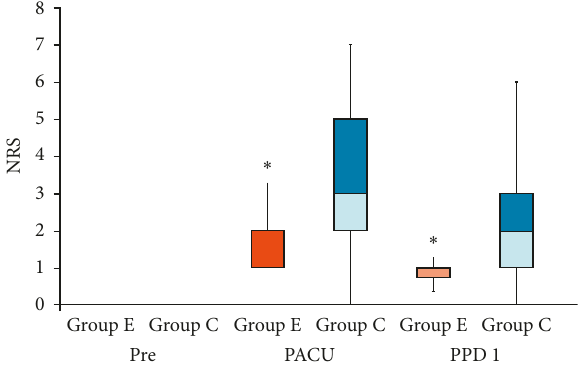
Figure 2: The 11-point numerical rating scale (NRS-11) score reported by patients after percutaneous radiofrequency ablation (PRFA). Pre before procedure; PACU (cid:31) PPD 1 postprocedure day (cid:31)